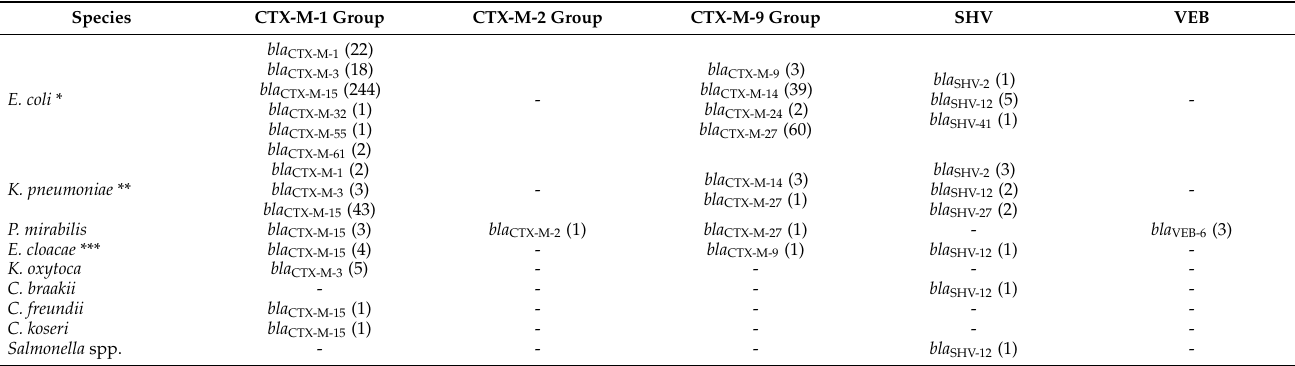
Figure 2. Bla genes coding for ESBL phenotypes isolated from ( A ) E. coli and ( B ) K. pneumoniae in absolute numbers and in (%). Left groupwise comparison; right genewise comparison. CTX-M-15 was also the most widespread enzyme among the other species. Bla VEB-6 was detected three times (all in P. mirabilis isolates) and only one bla CTX-M-2 also in one P. mirabilis isolate was detected, none of those were carrying another ESBL gene (Table S1). There were eight E. coli , four K. pneumoniae , and one E. cloacae , each carrying two different ESBL genes (Table 3). Table 3. ESBL coding genes detected and the number of isolates with those genes